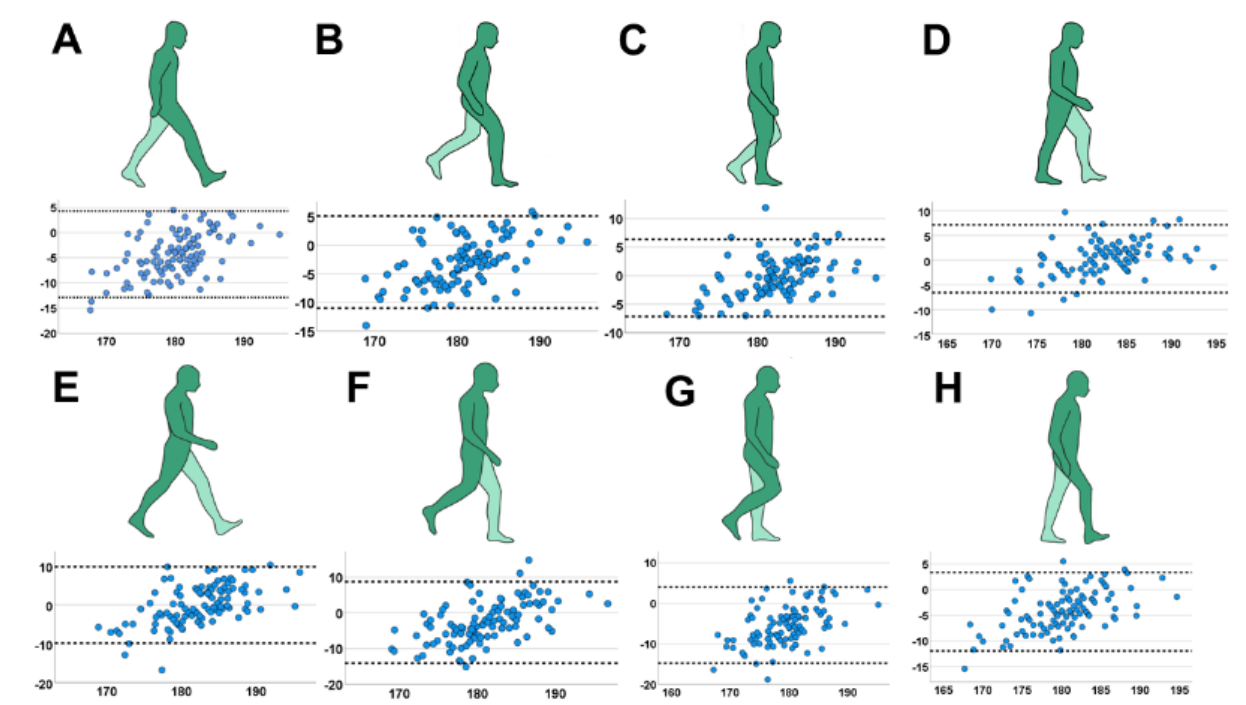
Figure 4. Leg axis analysis in specific gait cycles with Bland – Altman plot indicating systemic bias of the MAA ( X -axis: mean MAA between static radiograph and marker-based measurement; Y -axis: difference in MAA between both techniques). ( A ) initial contact; ( B ) loading response; ( C ) mid- stance; ( D ) terminal-stance; ( E ) pre-swing; ( F ) initial-swing; ( G ) mid-swing; ( H ) terminal-swing.